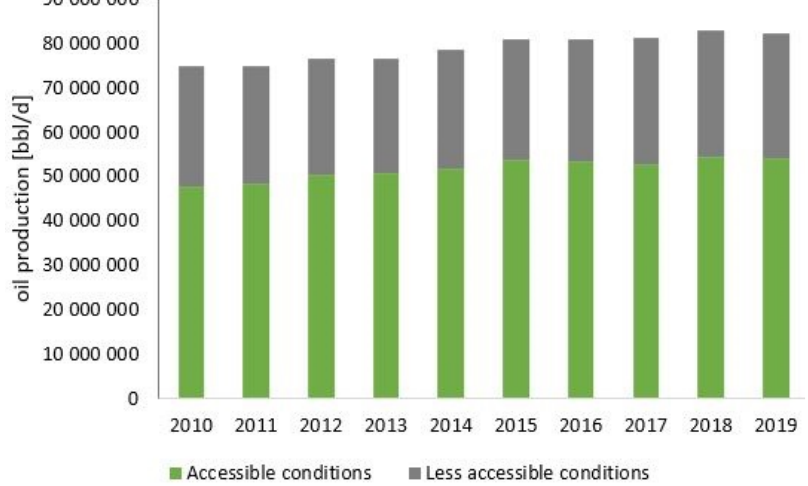
Figure 3. Yearly oil production according to the conditions of